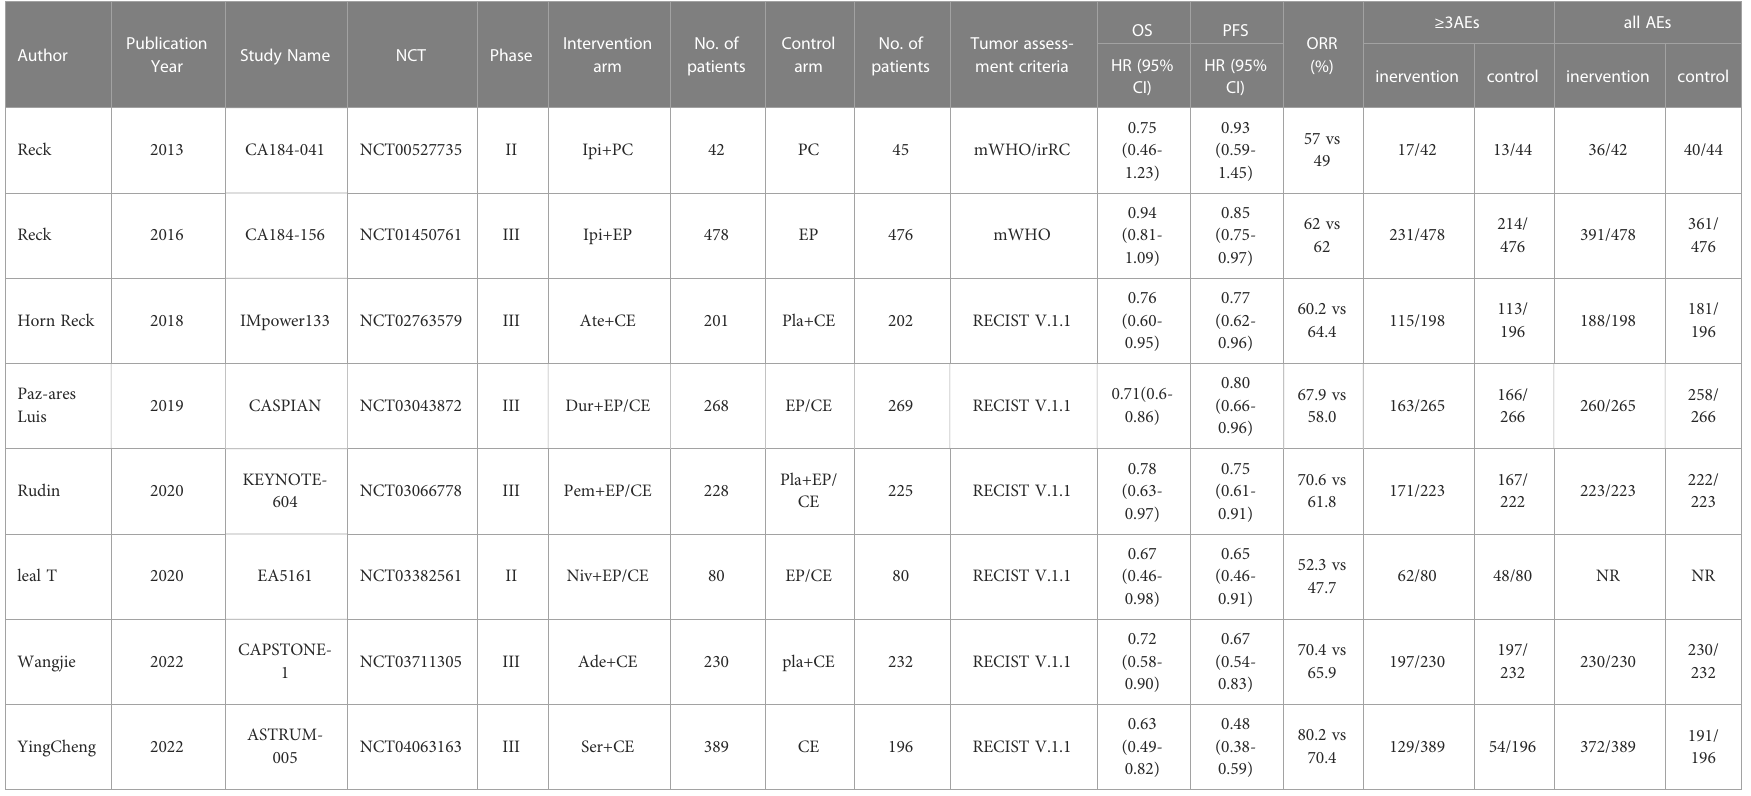
TABLE 1 Characteristics of studies included in the